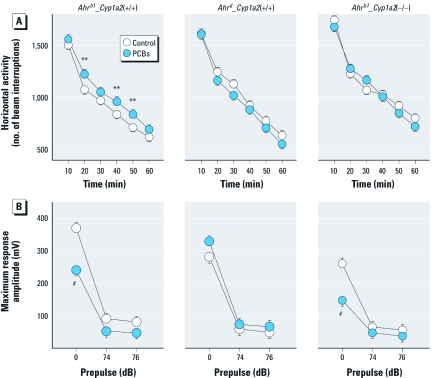
Results of locomotor activity (60 min; A) and ASR-PPI (B) tests (mean ± SE). **p < 0.01, and #p < 0.001 compared with controls of the same genotype.